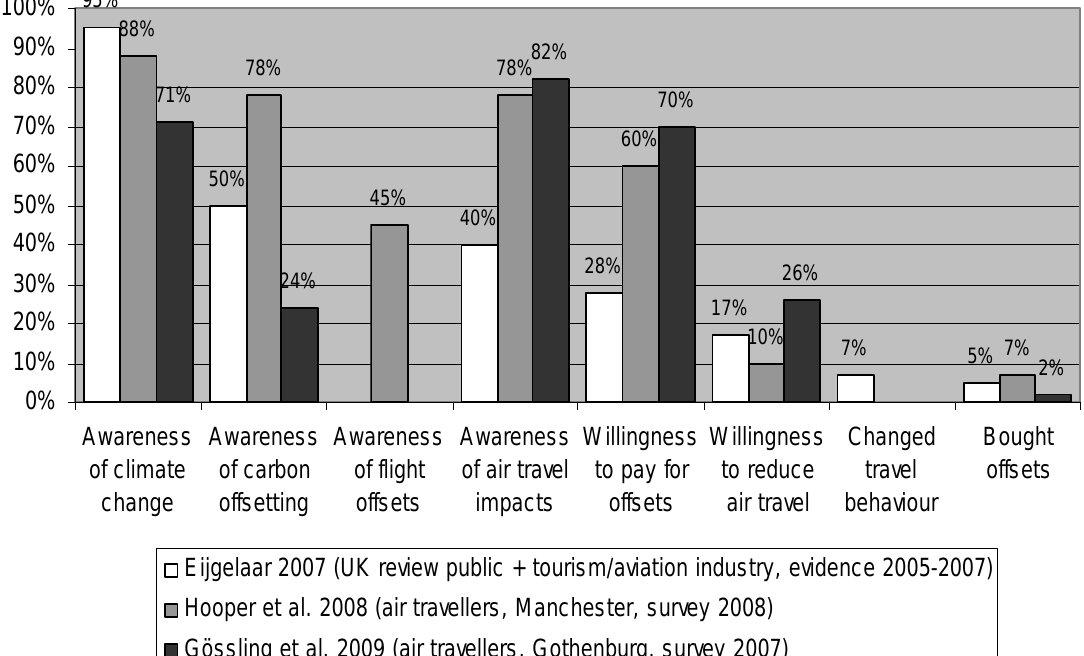
Figure 2. Levels of awareness, attitude and behaviour regarding climate change, air travel and